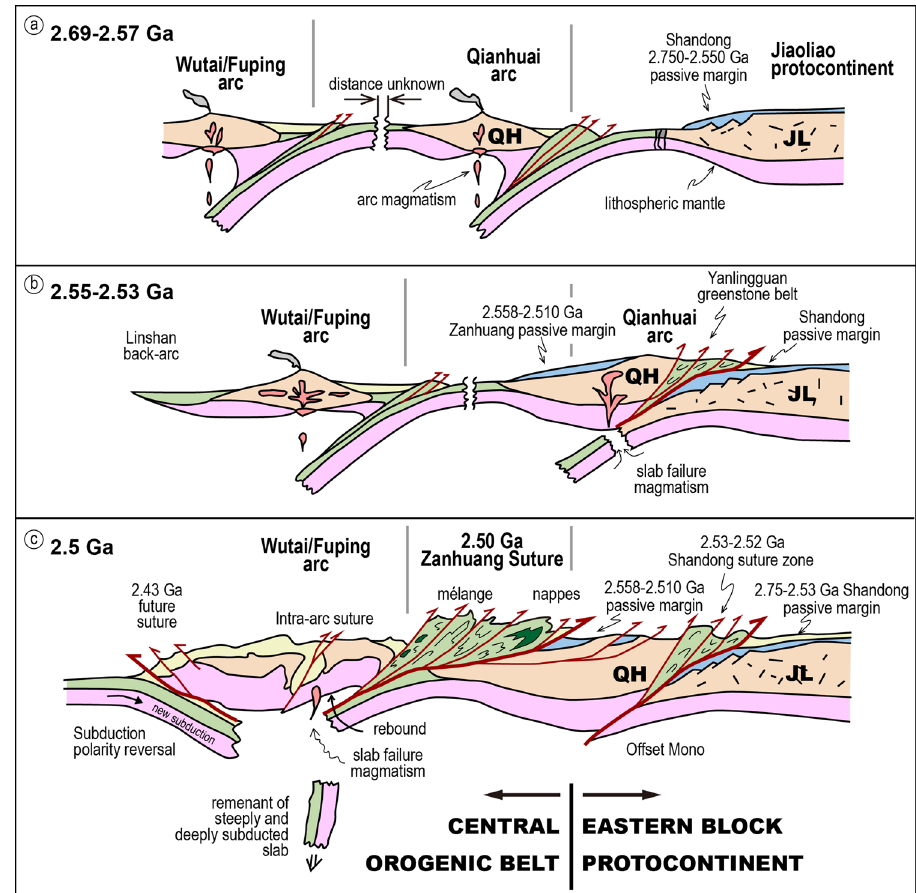
Fig.9|Schematicofregionaltectonicevolution.a EBprotocontinentformedbyarcamalgamationbeforeca.2.55Ga. b Fromca.2.55Gathemarginsubsidedforminga passive margin. c At ca. 2.51Ga, arc-continent collision caused nappe emplacement 17 and termination of passive margin